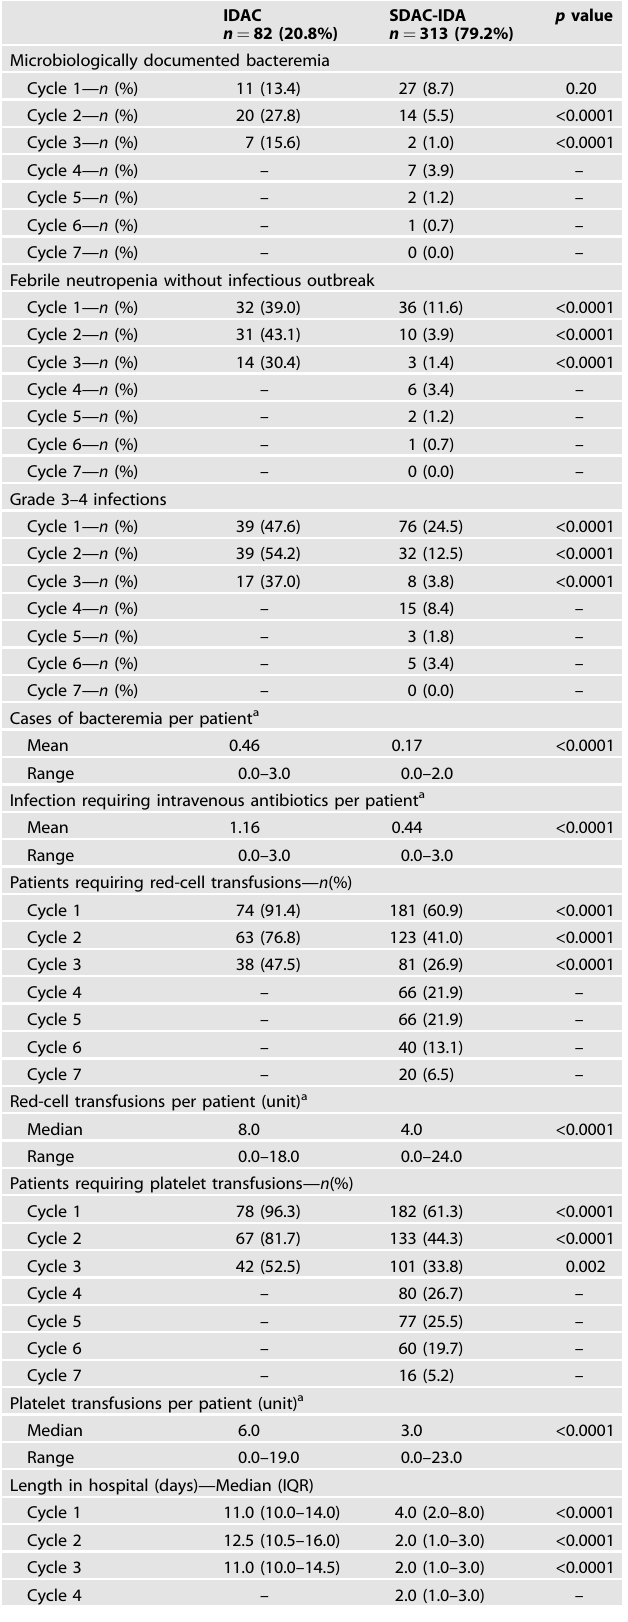
Table 1. Impact of post-remission schedule on infections and health care resource